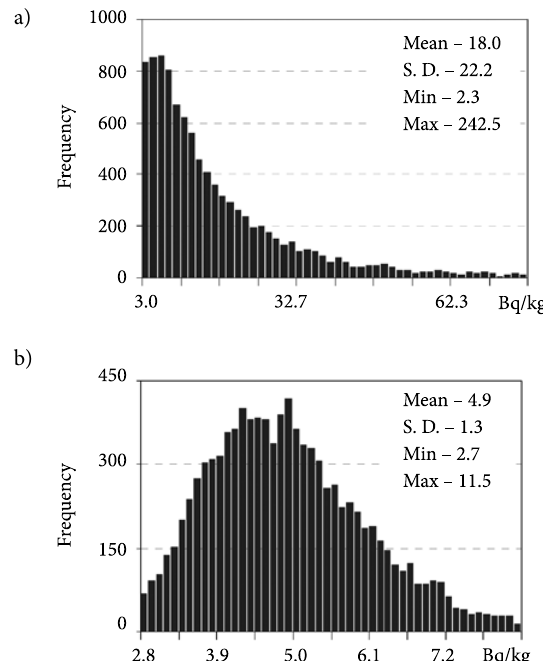
Fig. 4. Frequency histograms of 137 Cs (a) and 90 Sr (b) activity concentrations after the Chernobyl accident in Lithuanian top soils